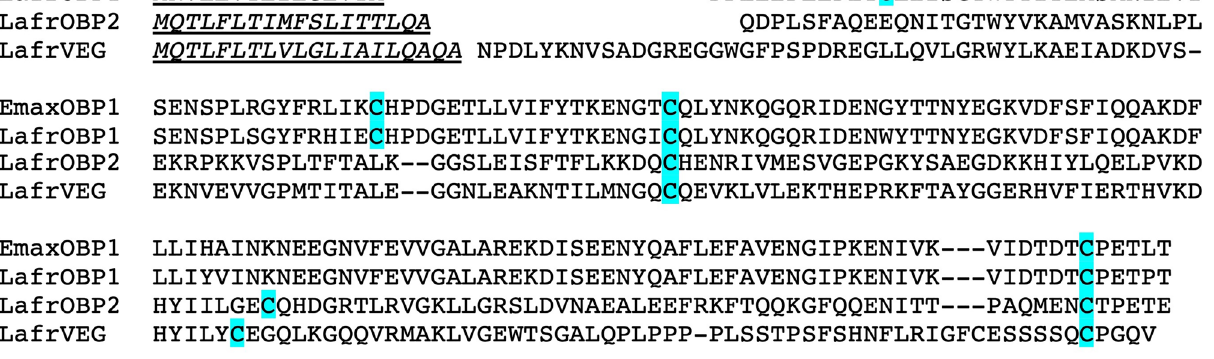
Figure 1. Two orthologous sequences in the Asian elephant Elephas maximus (EmaxOBP1: AAN17333) and in the African elephant Loxodonta africana (LafrOBP1: XP_023395442) share 93% of their residues and are annotated as OBP1. Another sequence, found only in the African elephant (LafrOBP2: SP_tr|G3U771) is only 15% identical with LafrOBP1. In addition, a member of the VEG proteins, found only in the databases of the African elephant (LafrVEG: XP_023398512.1), is 13% and 31% identical with LafrOBP1 and LafrOBP2, respectively. Predicted signal peptides are indicated in italics and underlined. The sequence of EmaxOBP1 is found in the databases as reported, without a signal peptide. Cysteine residues are